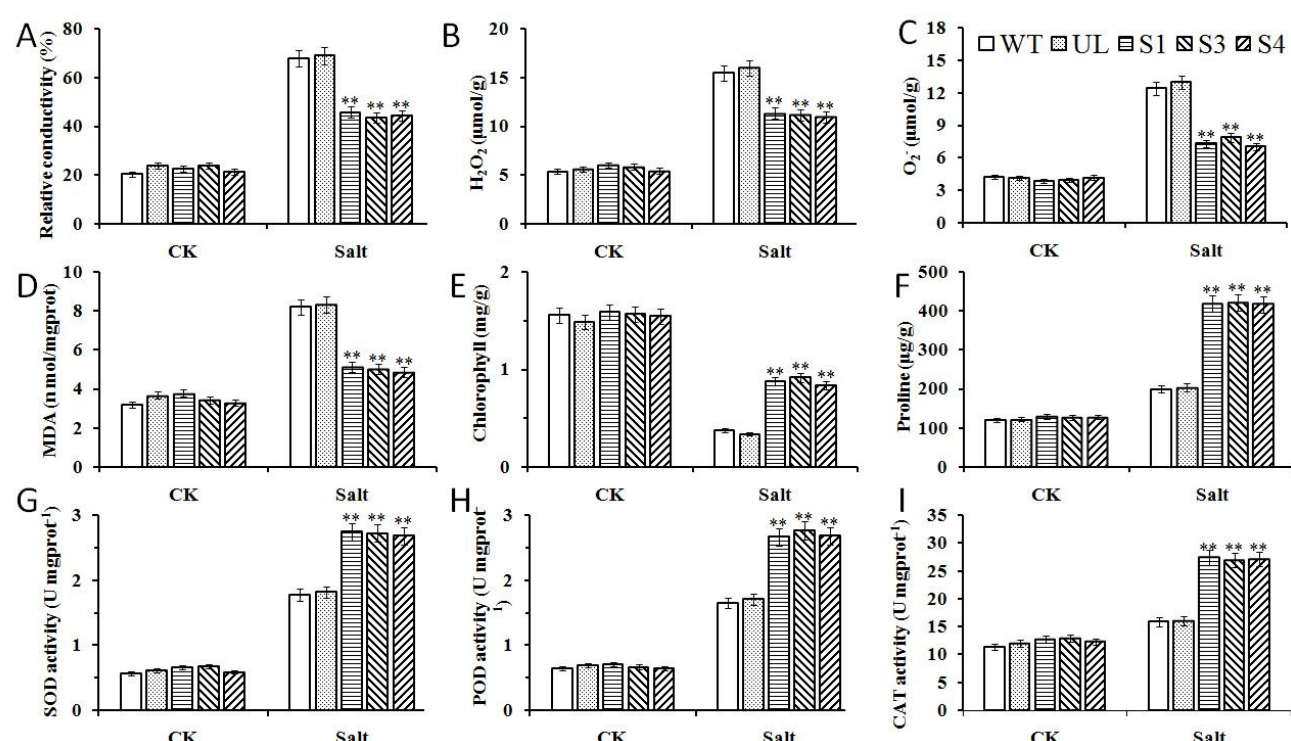
Figure 5. Overexpression of MxbHLH18 in A. thaliana improved salt tolerance. Effects of MxbHLH18 gene on ( A ) Relative conductivity, ( B ) H 2 O 2 content, ( C ) O 2 − content, ( D ) MDA, ( E ) chlorophyll, ( F ) proline content and ( G ) SOD, ( H ) POD, ( I ) CAT enzyme activities in A. thaliana under salt stress. Data represent means and standard errors of three replicates. Asterisks above columns indicate significant difference compared to that in WT (** p ≤ 0.01).